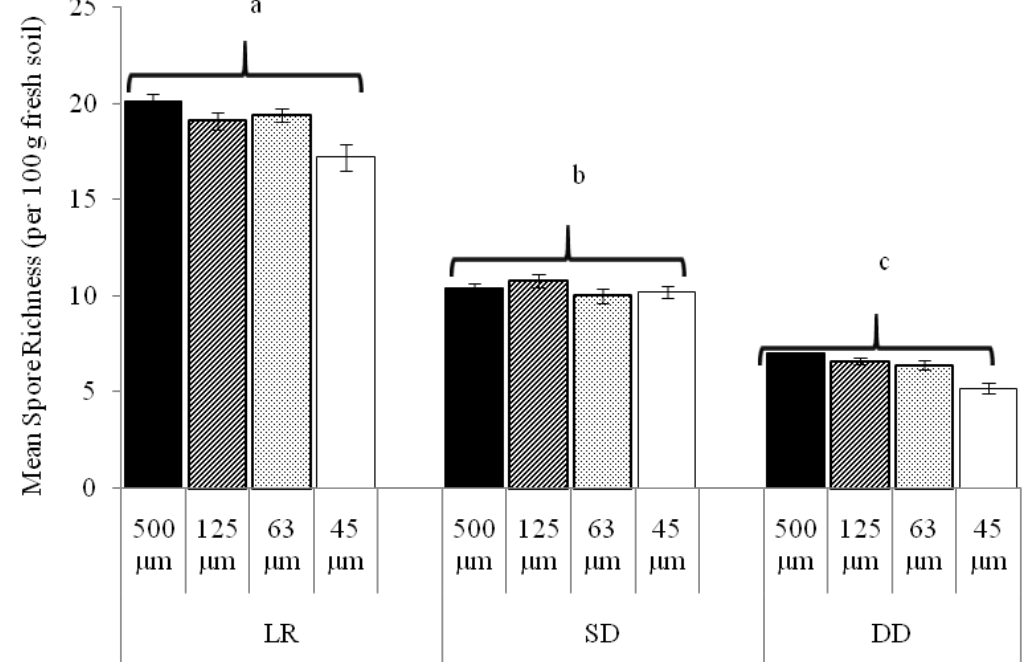
Figure 3: Mean richness of arbuscular mycorrhizal fungal (AMF) spores (per 100 g fresh soil) under 4 size categories (500, 125, 63 and 45 µm in natural forest (LR), shrub-dominated site (SD) and Dicranopteris dominated fernland (DD) at Kanneliya Forest Reserve, Sri Lanka. Each bar represents an average of 10 soil samples. Vertical bars represent the standard error of means (SEM). The different letters indicate significant differences between land use types. In all three land use types, no significant differences were observed in AMF richness between the four size categories. ANOVA: n = 40, F = 932.67, p =